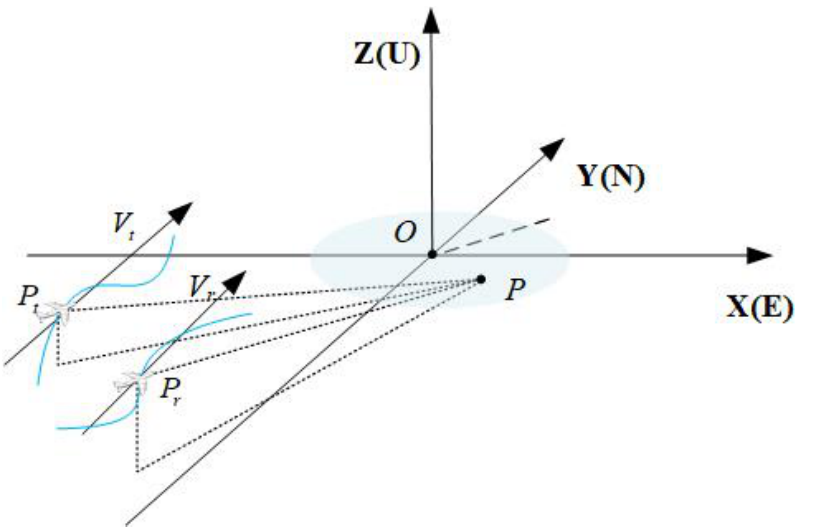
Figure 2. The configuration of the UAV-based BiSAR